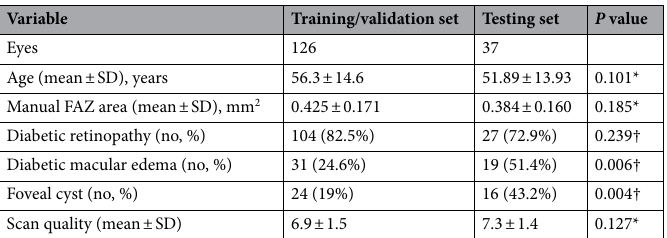
Table 1. Baseline characteristics of training/validation and testing set. FAZ Foveal avascular zone. *Student’s t -test. † Chi-square test.